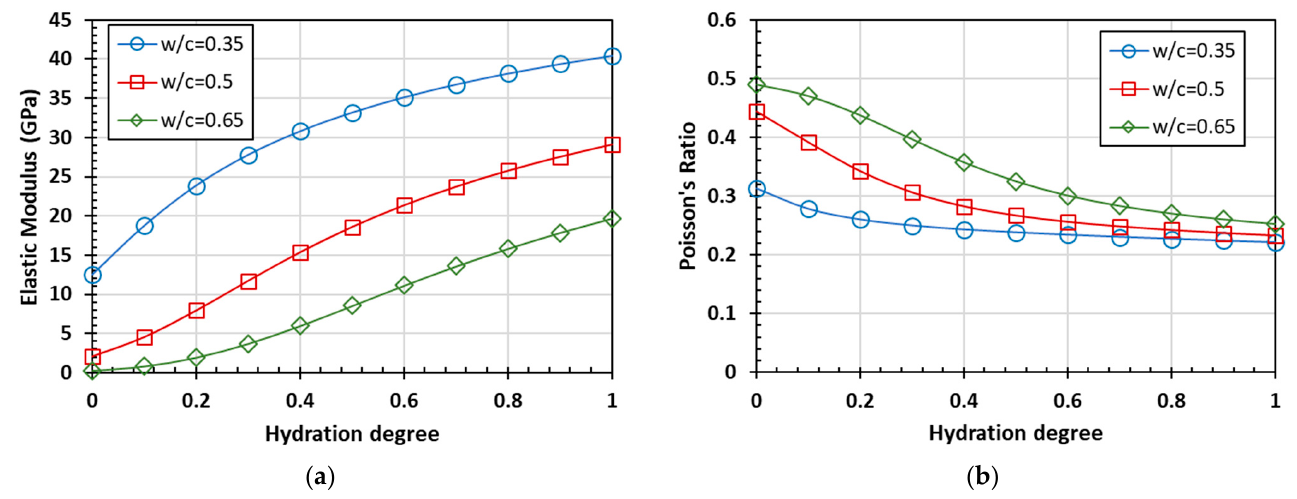
Figure 6. The predicted elastic parameters of mortar as a function of hydration degree: ( a ) elastic modulus and ( b ) Poisson’s ratio.